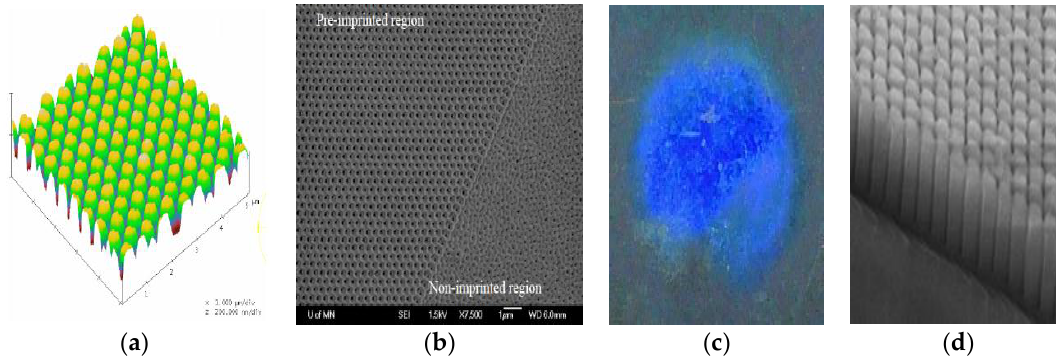
Figure 10. ( a ) Si 3 N 4 nanostamp to imprint Al films and foils so that ( b ) nanopores aligned in the subsequent oxide formed by anodization of the Al. ( c ) Line stamps of Ni could be made large enough to use for large area (1 cm in diameter) alignment, shown diffracting blue light. ( d ) Magnification of nanopores (1 μm long) produced by line stamps [23,26].